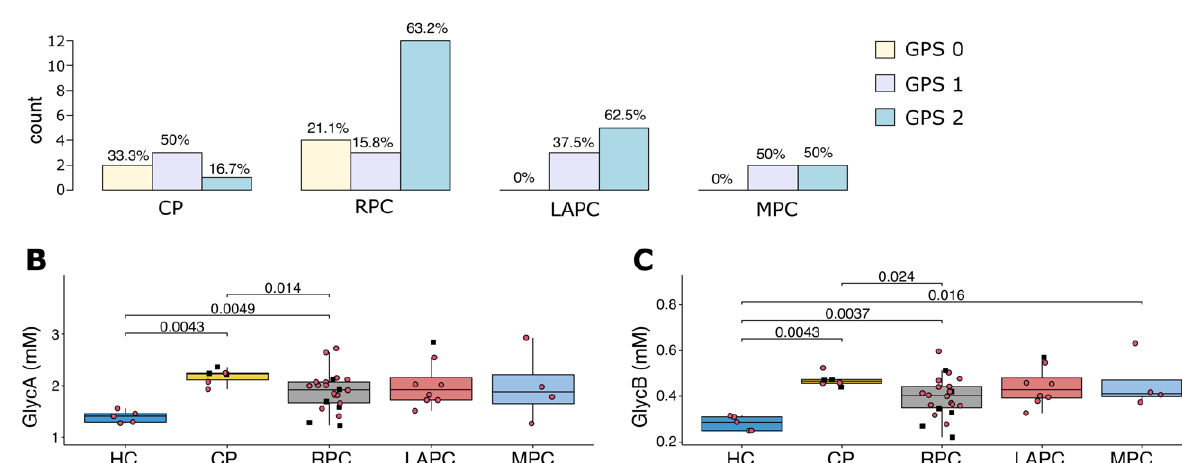
Figure 5. Inflammation status in patient groups ( A ) shows the inflammation levels of PDAC and CP groups using Glasgow Prognostic Score (GPS), CP (6) has the least inflammation and PDAC (RPC:22; LAPC: 8; MPC: 4.) groups are all highly inflamed. GlycA ( B ) and GlycB ( C ) show the comparison of the inflammatory status of PDAC and control groups (HC and CP) using GlycA and GlycB biomarkers, respectively. There was no difference observed across the groups for both GlycA and GlycB levels except when compared with the HC. The black square boxes represent T2DM patients. Red circles represent patients with no T2DM. T2DM: Type 2 Diabetes Mellitus; PDAC: Pancreatic Ductal Adenocarcinoma; HC: Healthy controls; CP: Chronic Pancreatitis; RPC: Resectable Pancreatic Adenocarcinoma; LAPC: Locally Advanced Pancreatic Adenocarcinoma; MPC: Metastatic Pancreatic Adenocarcinoma.